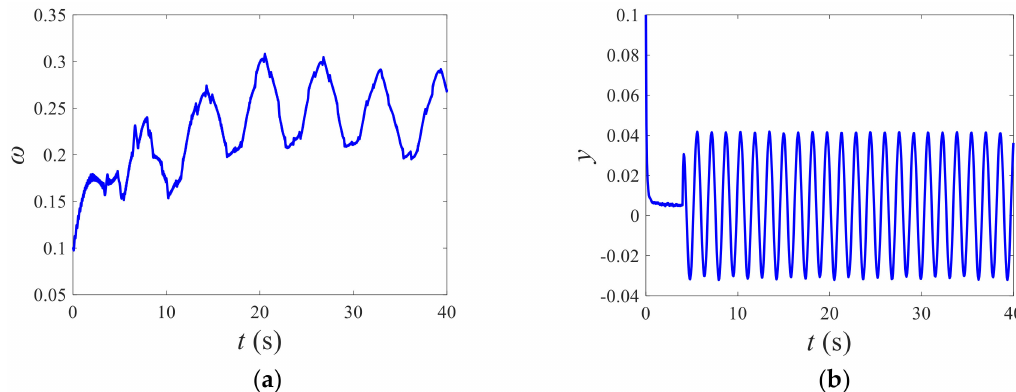
Figure 6. State trajectories of the HTGS under multiple faults without fault-tolerant control. ( a ) ω ( t ) − t ; ( b ) y ( t ) − t .